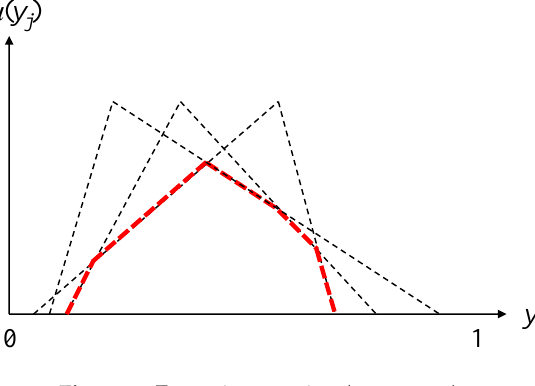
Figure 2. Fuzzy intersection (consensus).